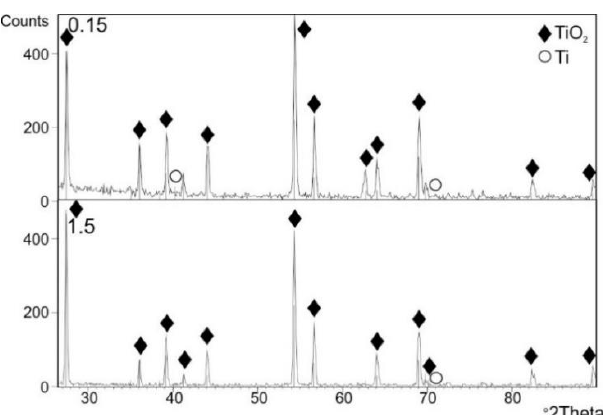
Figure 10. A set of diffraction patterns obtained by the GIXD method at beam incidence angles α = 0.15° and 1.5°, for a titanium Grade 2 specimen after cyclic oxidation (12 cycles) at 650 °C.